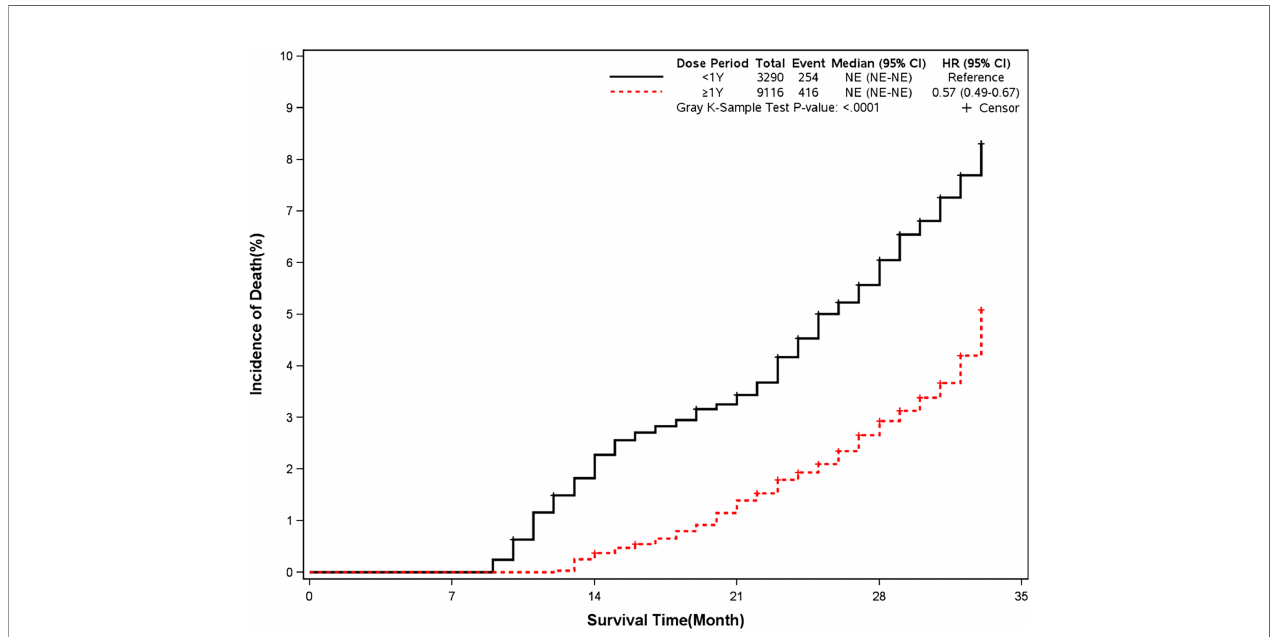
FIGURE 2 | Incidence of all-cause death in two groups. Blackline: patients took clopidogrel continuously < 1 year; Red line: patients took clopidogrel continuously ≥ 1 year.